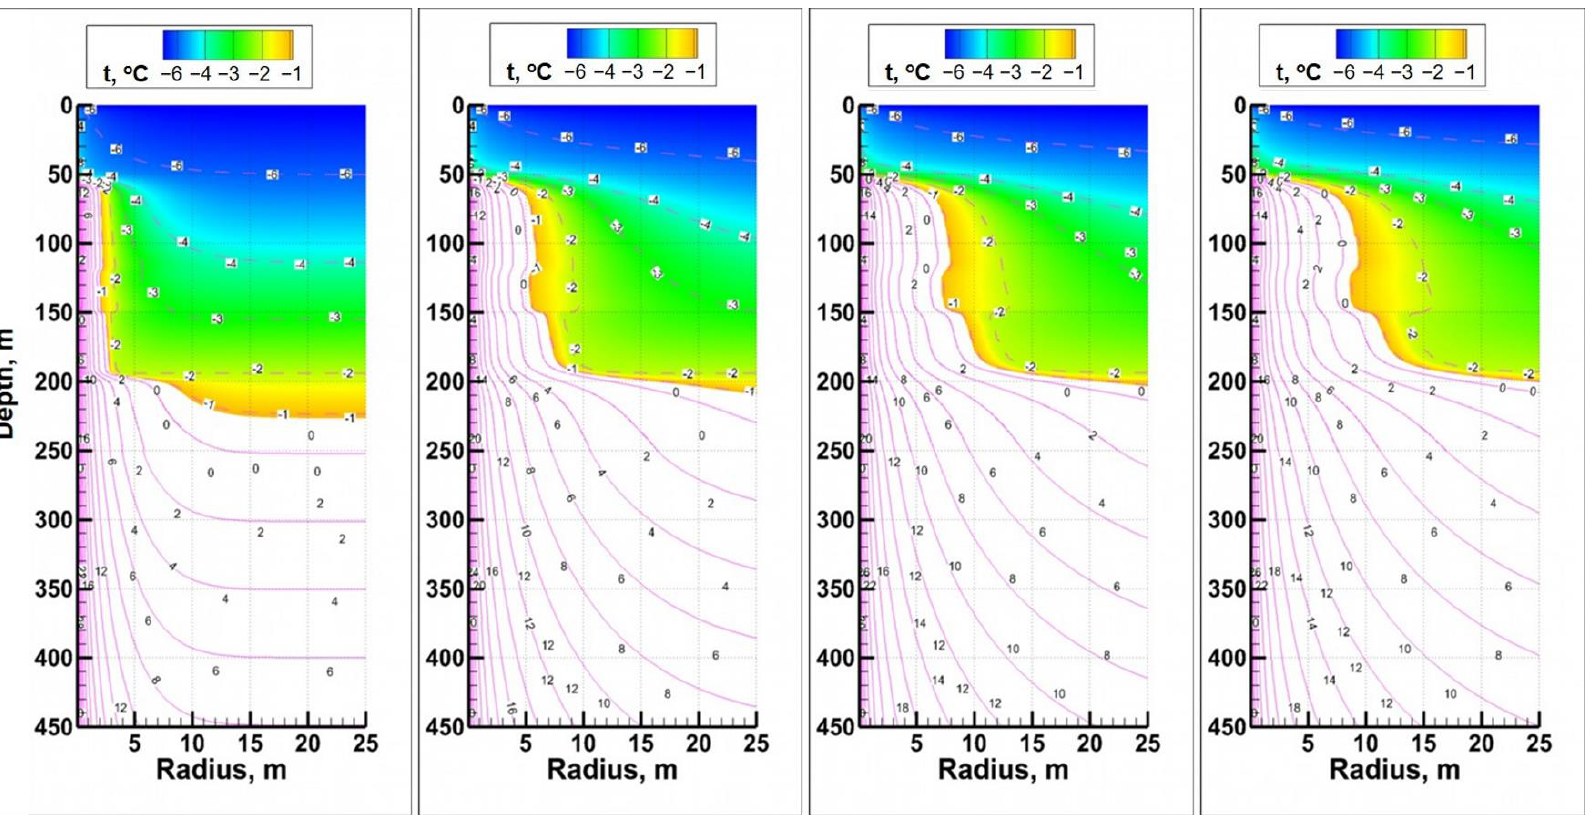
Figure 7. Permafrost temperature variations around a producing gas well (along the radius off the well center) after 1, 10, 20, and 30 years of operation (left to right). Permafrost contained gas hydrates within the depth interval of 60 ‒ 120 m, with hydrate saturation 𝑆 ℎ = 20%; hydrate and ice saturation 𝑆 ℎ + 𝑆 𝑖 = 70%.